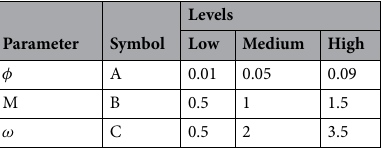
1 / 2 1 / 2 1 / 2 r is also r , C g θ ∗ Re r and Nu r Re −